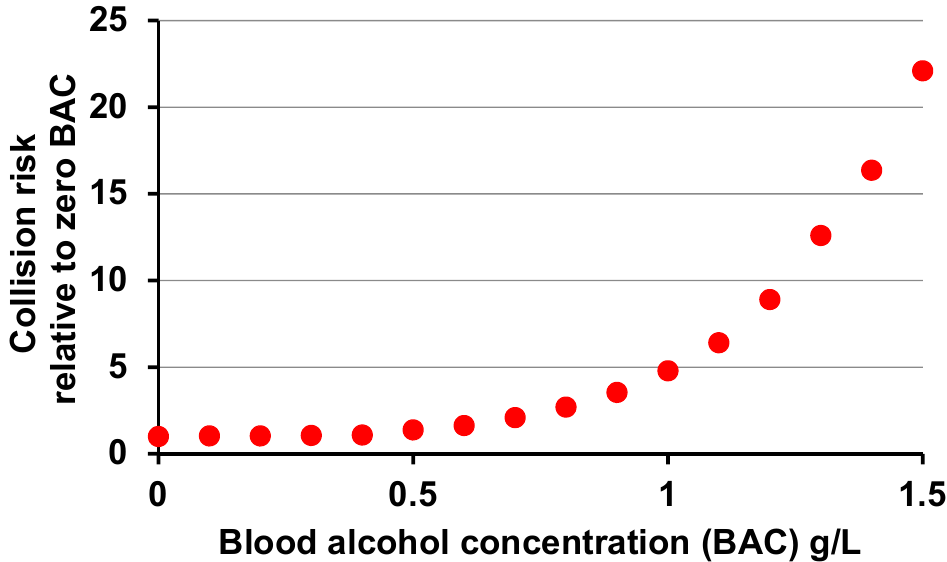
Figure 1. Variation in the risk of involvement in a collision, however slight, with level of alcohol in the blood as estimated in a repeat of the Grand Rapids study by Compton et al. [8].